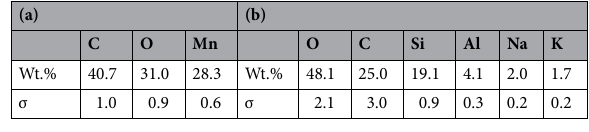
Table 1. EDS results for (a) Micromax and (b)